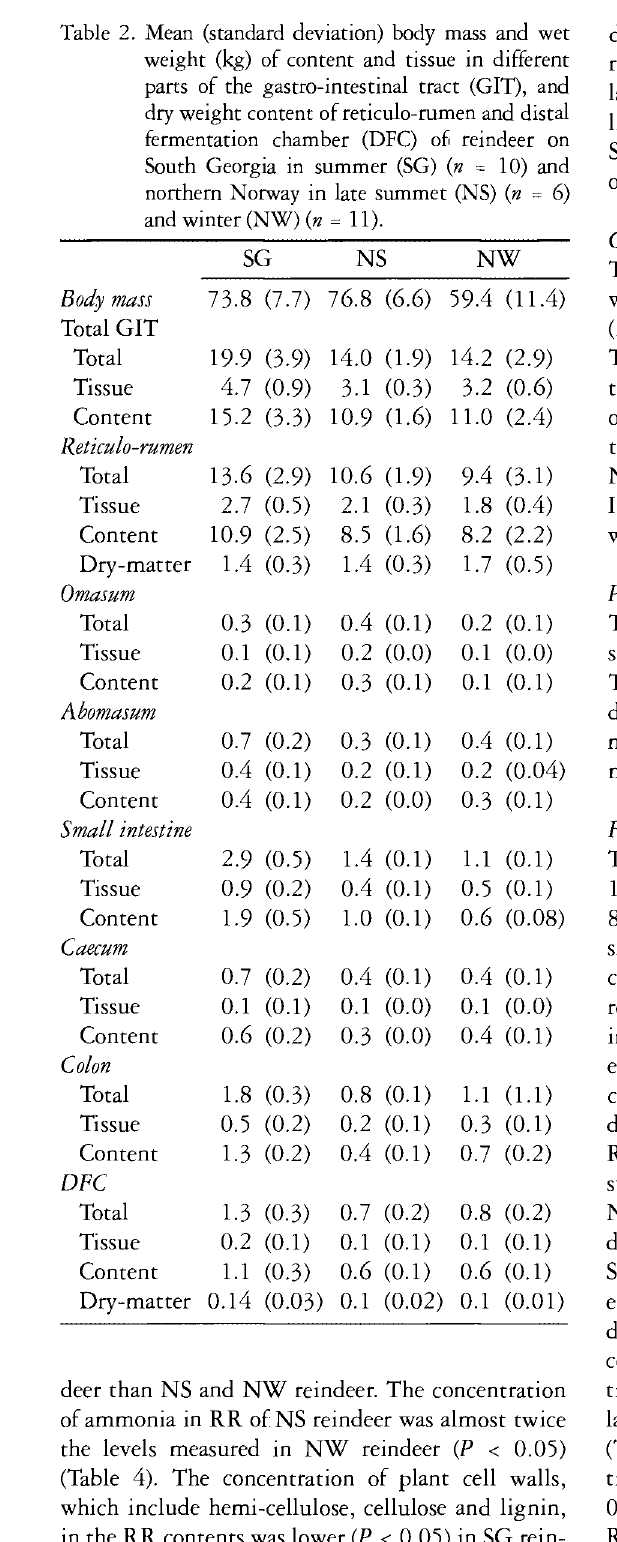
(Table 4). The concentration of plant cell walls, which include hemi-cellulose, cellulose and lignin, in the RR contents was lower (P < 0.05) in SG rein